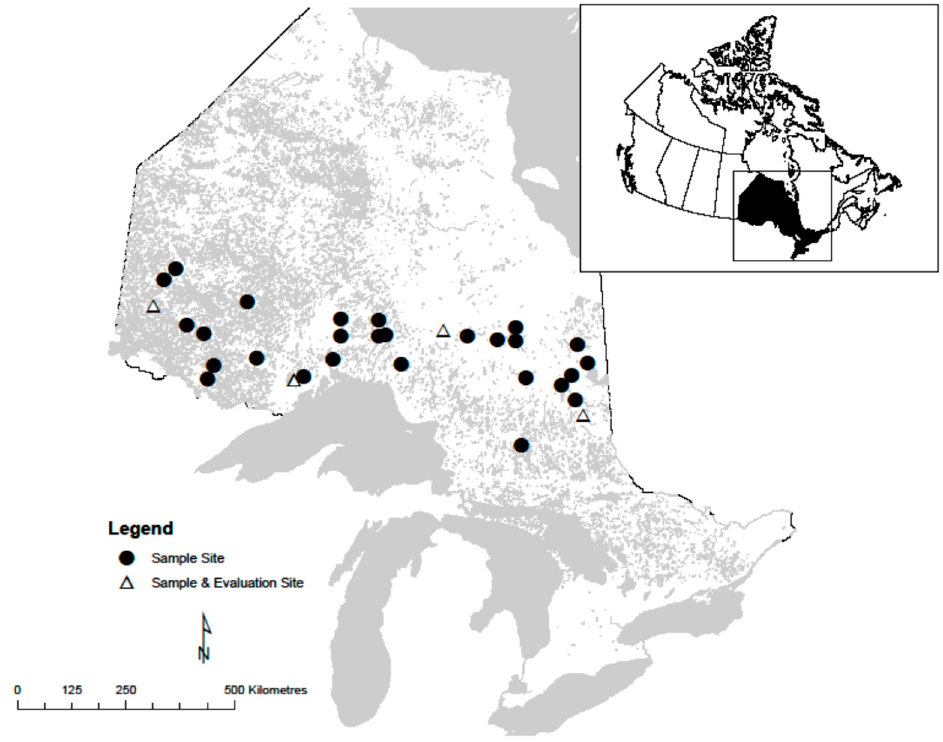
Figure 1. Distribution of natural origin black spruce and trembling aspen sites sampled across northern Ontario, Canada.